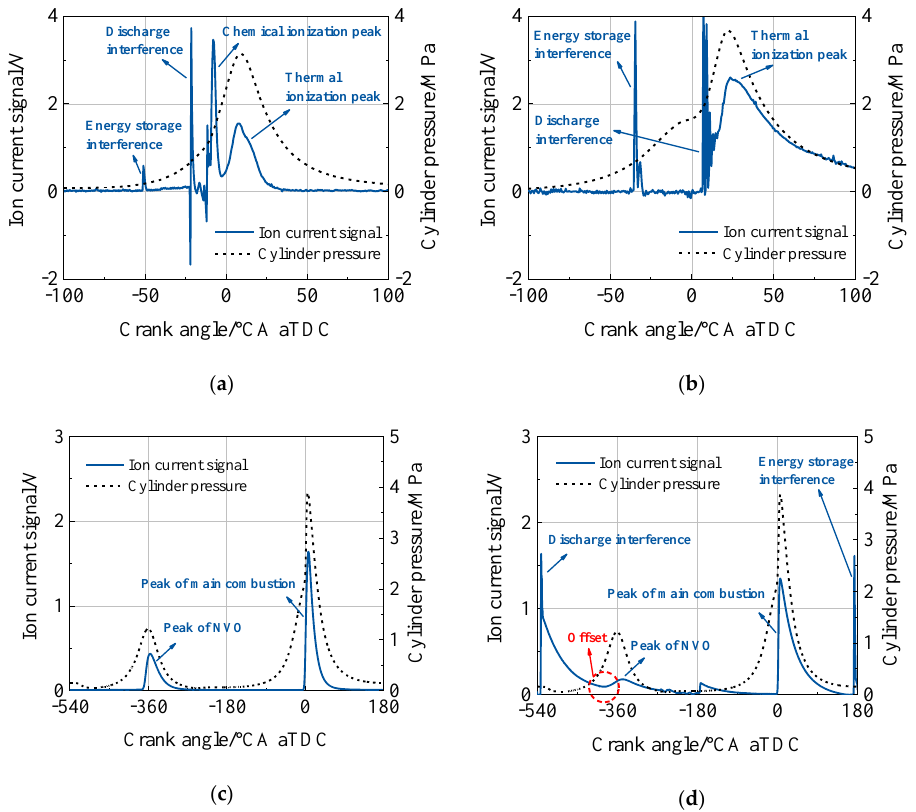
Figure 3. Typical ion current signals measured by two ion current detection systems in SI (1500 r / min, IMEP = 0.28 MPa, Ignition timing = − 22 ◦ CA aTDC (after Top Dead Center)) and HCCI modes (1500 r / min, IMEP = 0.3 MPa): ( a ) DC-Power type in SI mode; ( b ) Capacitive type in SI mode; ( c ) DC-Power type in HCCI mode; ( d ) Capacitive type in HCCI